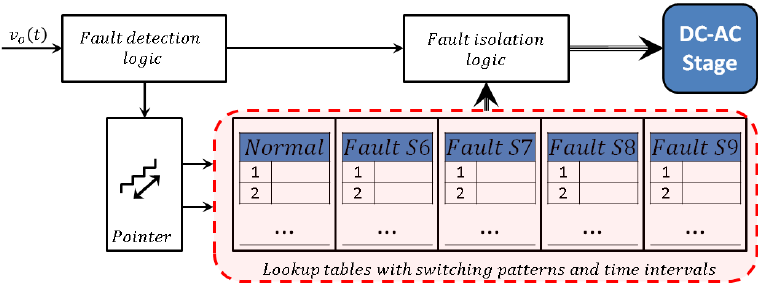
Figure 3. Description of steeped signal along with external and internal